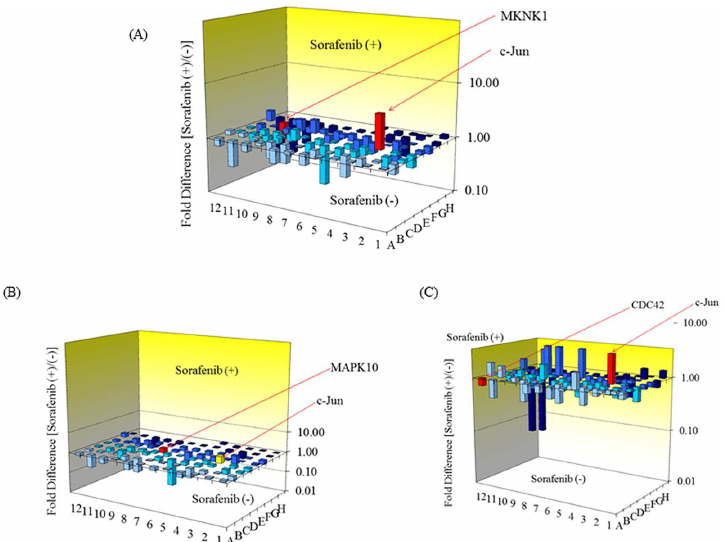
Fig 2. Changes of MAPK-signaling pathway-associated genes in human hepatoma cell lines treated with or without sorafenib. Six human hepatomacell lines were treated with or without 10 μ M sorafenibfor 12 hours. (A) Total expressionof 6 human hepatomacells (PLC/PRF/5, HepG2.2.15,Huh6, Hep3B, HepG2 and Huh7). Expression of 2 genessignificantly changedafter 12 hours of treatment with sorafenib: Jun proto- oncogene (c-Jun) and MAP kinase interacting serine/threonine kinase 1 (MKNK1), which are shown in red. (B) Human hepatomacells without HBV genome integration (Huh6, HepG2 and Huh7). Mitogen-activated protein kinase 10 (MAPK10) expressionsignificantly changedafter 12 hours of treatment with sorafenib. MAPK10 is shown in red, and c-Jun is shown in yellow. (C) Human hepatomacells with HBV integration(PLC/ PRF/5, HepG2.2.15 and Hep3B). Expression of 2 genessignificantlychangedafter 12 hours of treatment of sorafenib: c-Jun and cell division cycle 42 (GTP bindingprotein,25 kDa) (CDC42), which are shown in red.